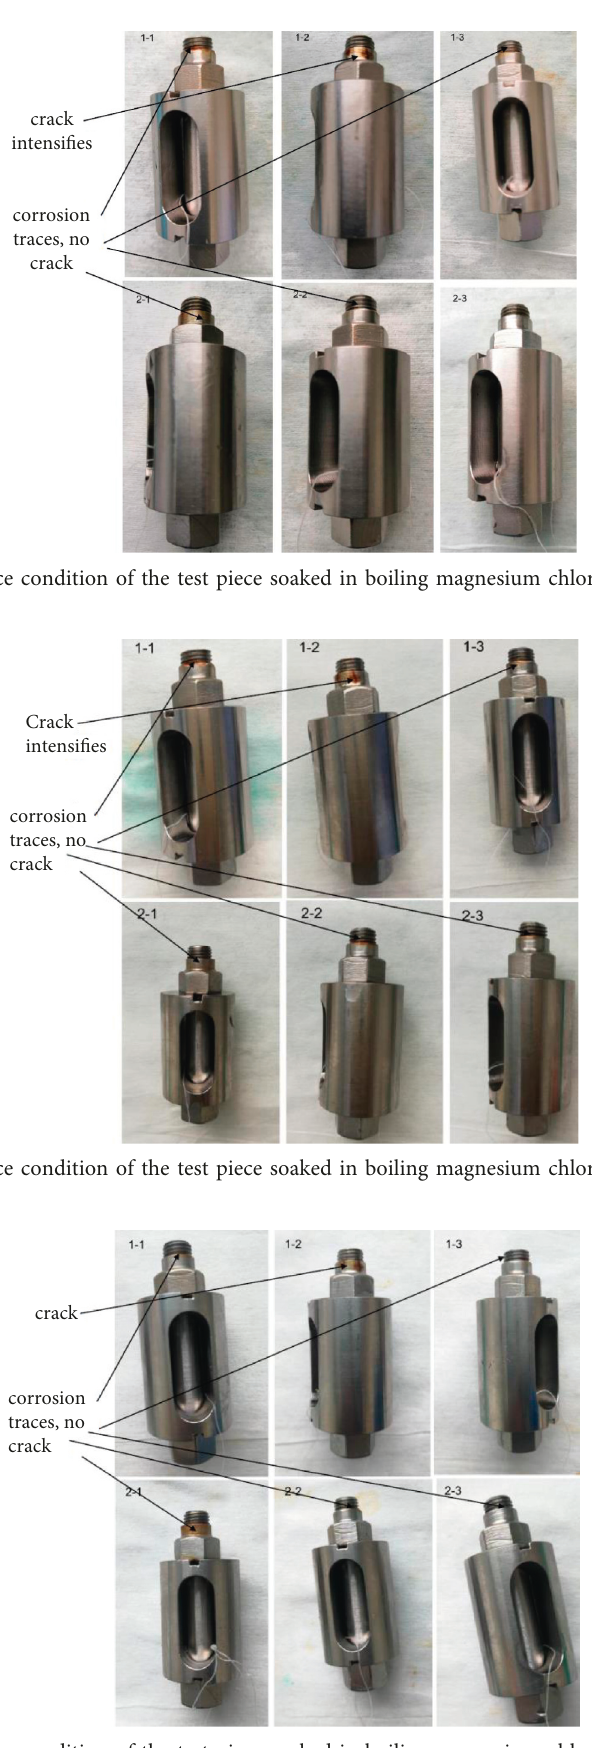
Figure 14: The surface condition of the test piece soaked in boiling magnesium chloride solution for 32